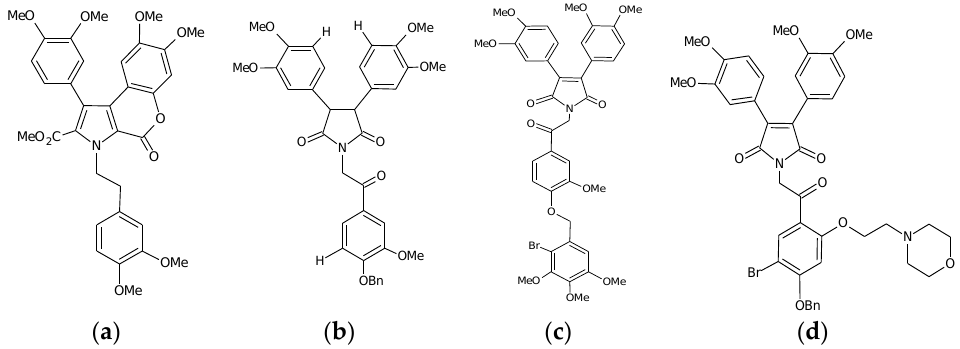
Figure 1. Ningalin B compounds which act as potent P-gp inhibitors, from references 45, 49, 50 and 51. ( a ) N3 [49]. ( b ) Compound 35. 1-(2-(4-(benzyloxy)-3-methoxyphenyl)-2-oxoethyl)-3,4-bis(3,4-